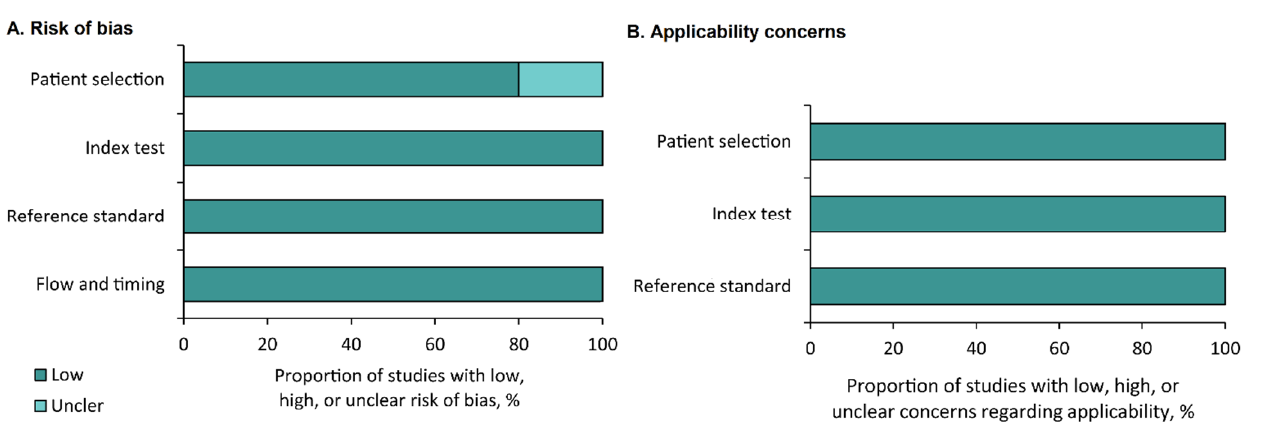
Figure 2. Summary of the results of the quality assessment using Quality Assessment of Diagnostic Accuracy Studies-2. Risk of bias ( A ) and applicability concerns ( B ).